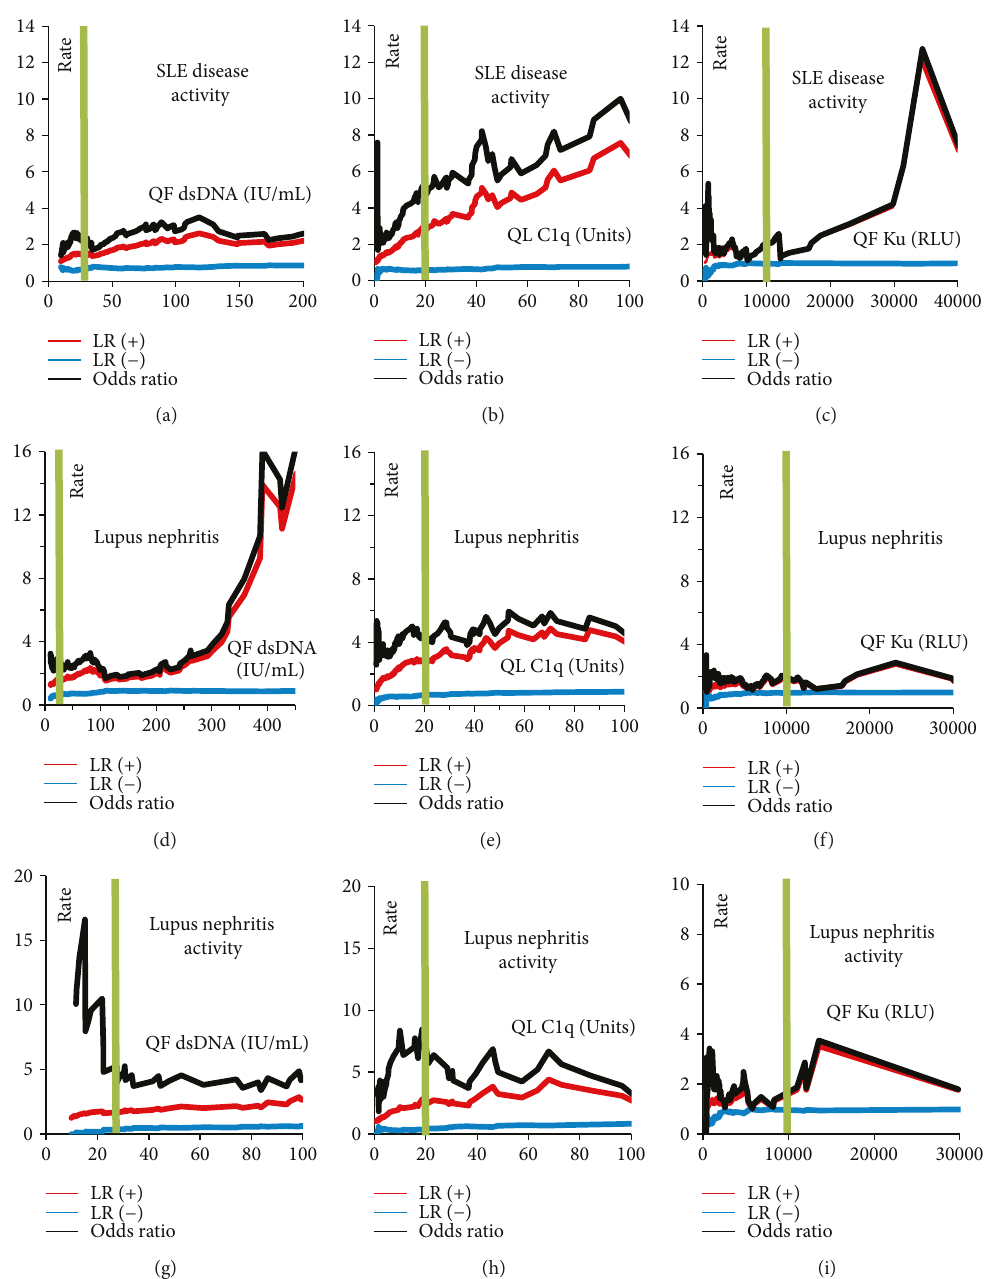
Figure 2: Likelihood plots for the assessment of disease activity, lupus nephritis, and lupus nephritis activity; likelihood ratios are shown as a function of antibody titer. Likelihood plots of the QUANTA Flash (QF) dsDNA, QUANTA Lite (QL) C1q, and anti-Ku chemiluminescent immunoassay (CIA) for disease activity (a – c), lupus nephritis (d – f), and lupus nephritis activity (g – i). The black line indicates the odds ratios (OR), while the red and blue lines denote the positive and negative likelihood ratios, respectively. Furthermore, the green vertical line represents the manufacturer ’ s cut-o ff point. The acronyms IU/mL and RLU stand for international units/mL and relative light units, respectively, which are assay unit values generated from the QF CIA